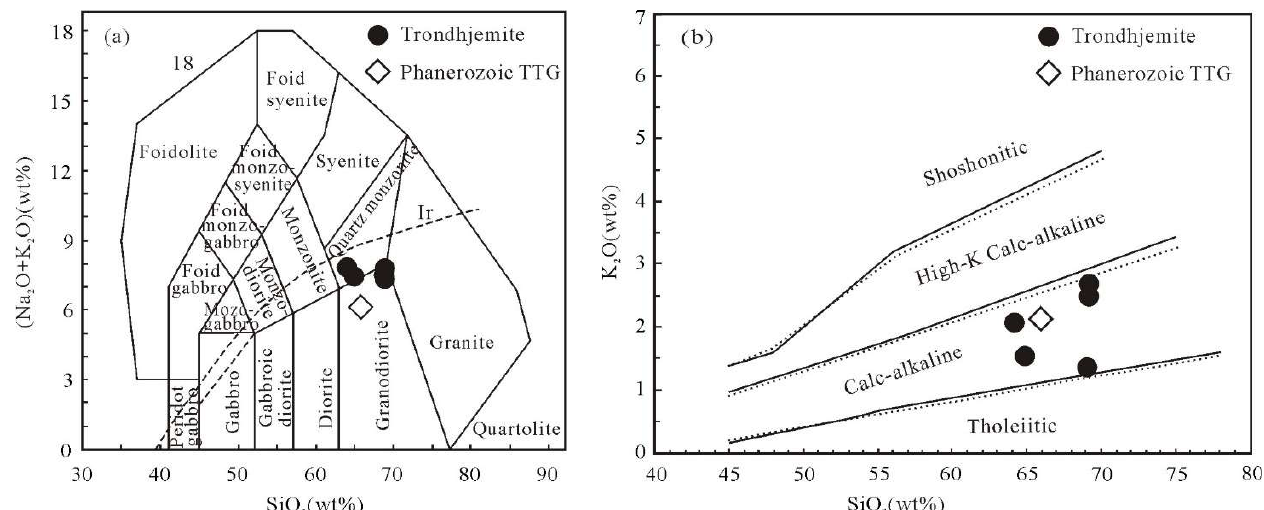
Figure 5. ( a ) SiO 2 vs. (K 2 O + Na 2 O) for trondhjemite [45]; ( b ) SiO 2 vs. K 2 O for the Gaolihan trondhjemite [46]. Phanerozoic TTG data are from Condie [6]. Figure 6 [6,40,41,47,48] shows that the trace-element patterns of the Gaolihan trondhjemite were consistent with those of Phanerozoic TTG, adakites within the Diyanmiao SSZ-type ophiolite, and Late Carboniferous tonalite, displaying enrichment in LILEs (K, Rb, and Sr) and depletion in HFSEs (Nb, Ta, and Ti), which was consistent with the island arc and oceanic subduction background [49,50].